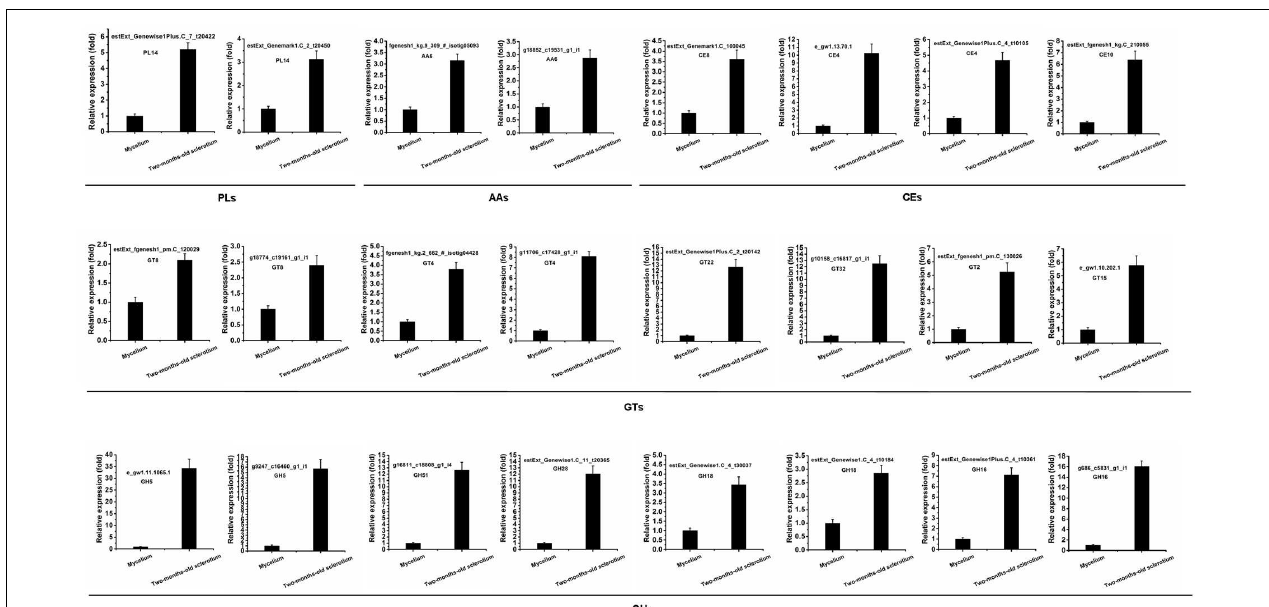
FIGURE 6 | qRT-PCR validation of differentially expressed CAZymes genes. The relative expression of target genes in mycelium stage was set as level 1. Expression of W. cocos alpha-tubulin gene was used to normalize different samples. Bars represent means and standard deviations (three replications).